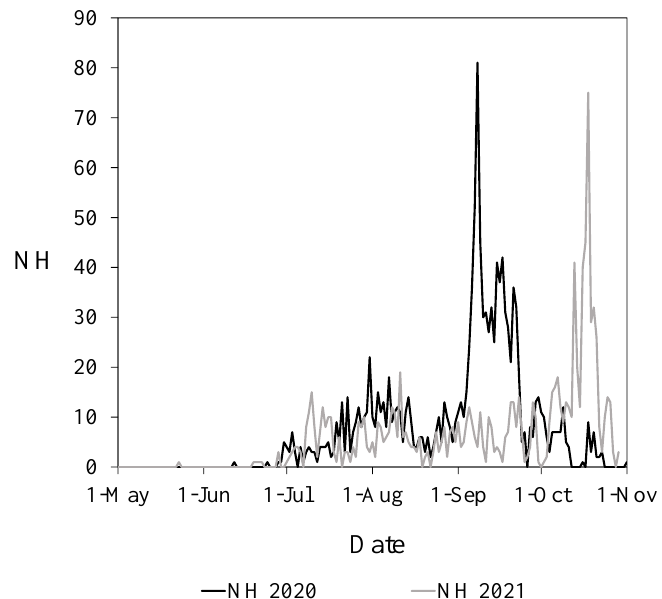
Figure 1. The total number of hornet sightings (NH) per day counted in the apiary by year (2020 and 2021).